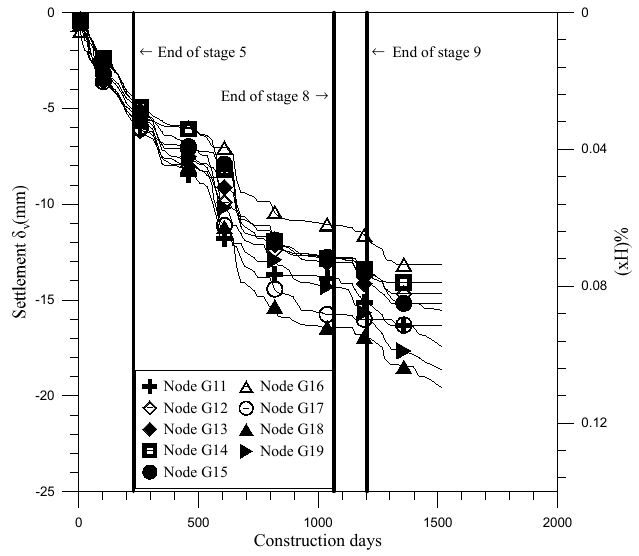
Figure 10. Ground settlement of points 4–10.